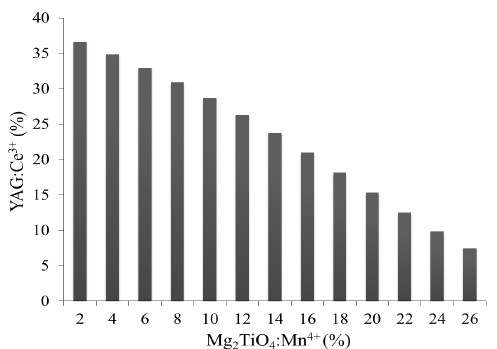
The in(cid:29)uence that the concentration of red phosphor Mg TiO 4 :Mn 4+ has on the emission 2 spectrum of WLEDs is most visible as in Fig. 3. Depending on the demand from the manufac- turers, a speci(cid:28)c level of phosphor concentration can be selected. For WLEDs required high color quality, we can compromise for a smaller lumi- nous (cid:29)ux so that the color quality can reach the highest index. White light is a combination between di(cid:27)erent emission spectra as displayed in Fig. 3. The Fig- ure illustrates the luminous (cid:29)ux of WLEDs with color temperature of 5600 K. The change of the red light spectrum following the concentration of Mg TiO 4 :Mn 4+ can be easily observed in the 2 wavelength from 648 nm to 738 nm. However, a more signi(cid:28)cant factor here is the increase in the emission spectrum at 420 nm (cid:21) 480 nm and 500 nm (cid:21) 640 nm, as the emission spectrum en- hancement in these two regions also bene(cid:28)ts the blue-light scattering e(cid:27)ect. The higher the color temperature, the higher the spectral emission, leading to the better color quality and luminous